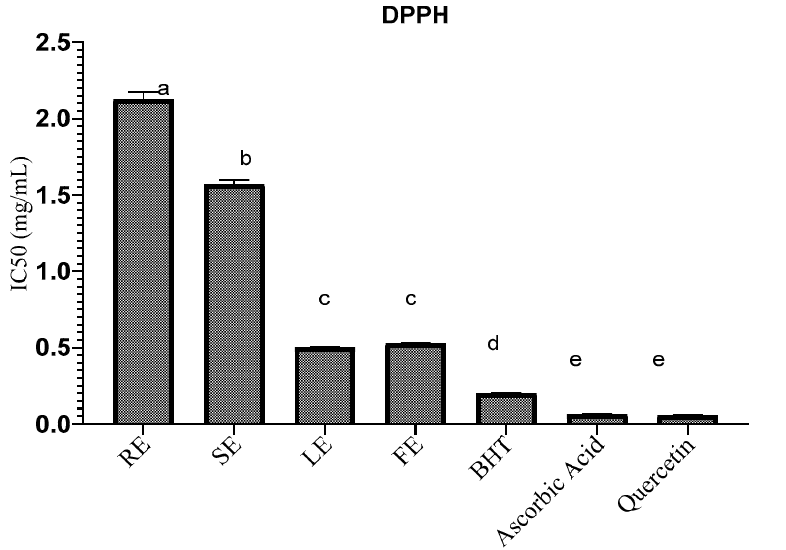
Figure 1. Antiradical activity (IC50) of Papaver rhoeas extracts; a, b, c, d and e—values with a significant difference.